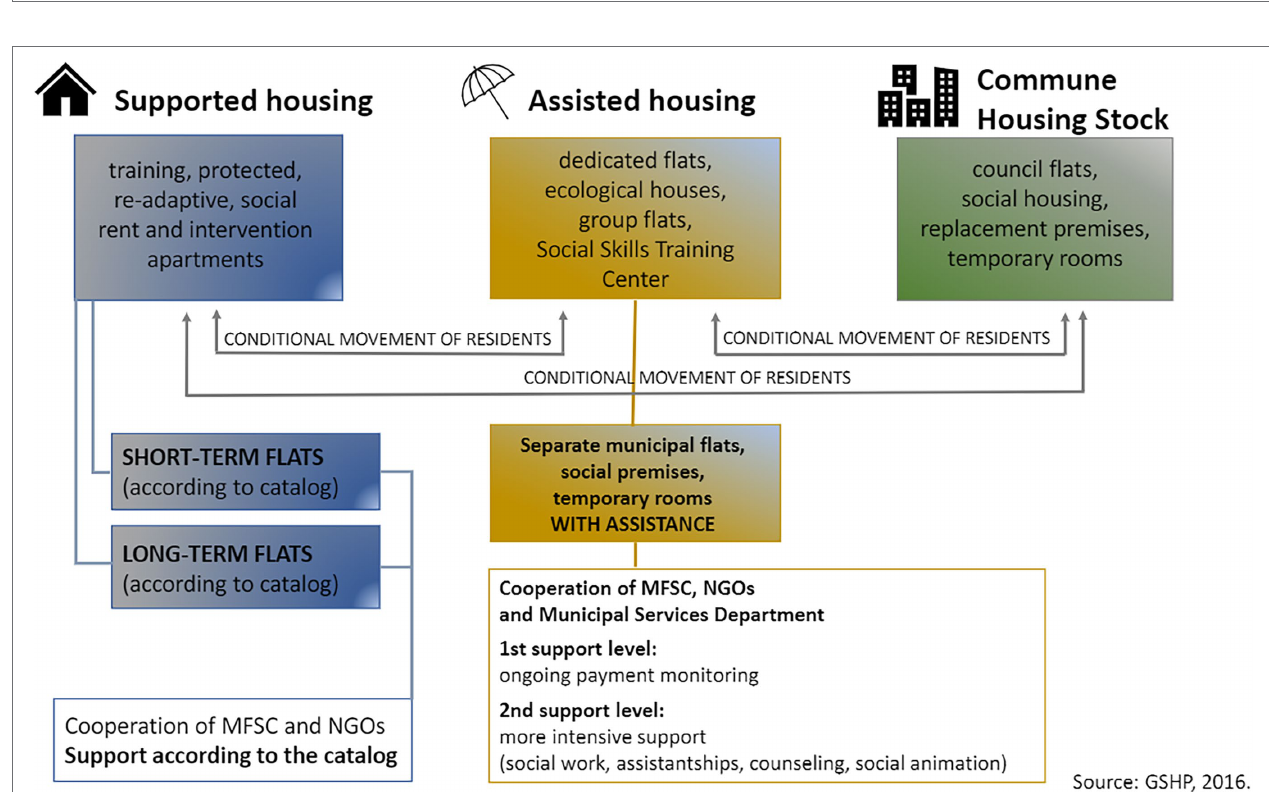
FIGURE 2 | Implementation of supported housing and assisted housing